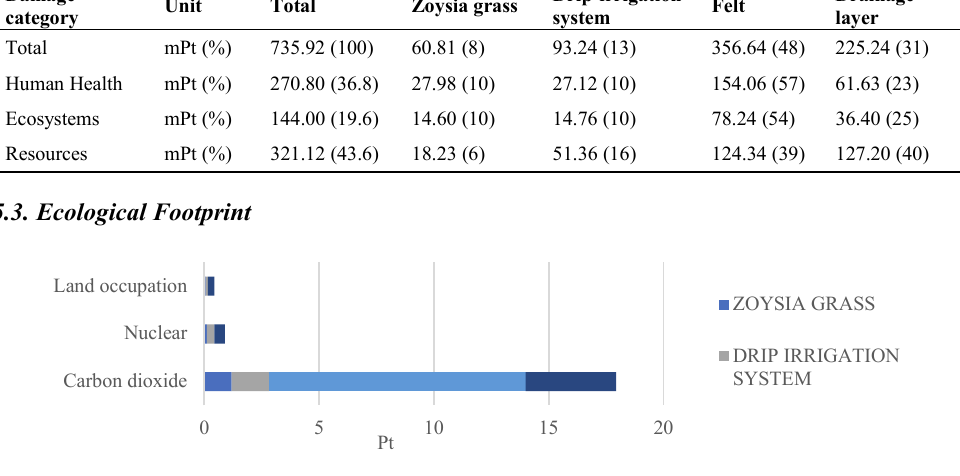
Fig. 5. Weighed impacts. Method: Ecological footprint V1.01 / Ecological